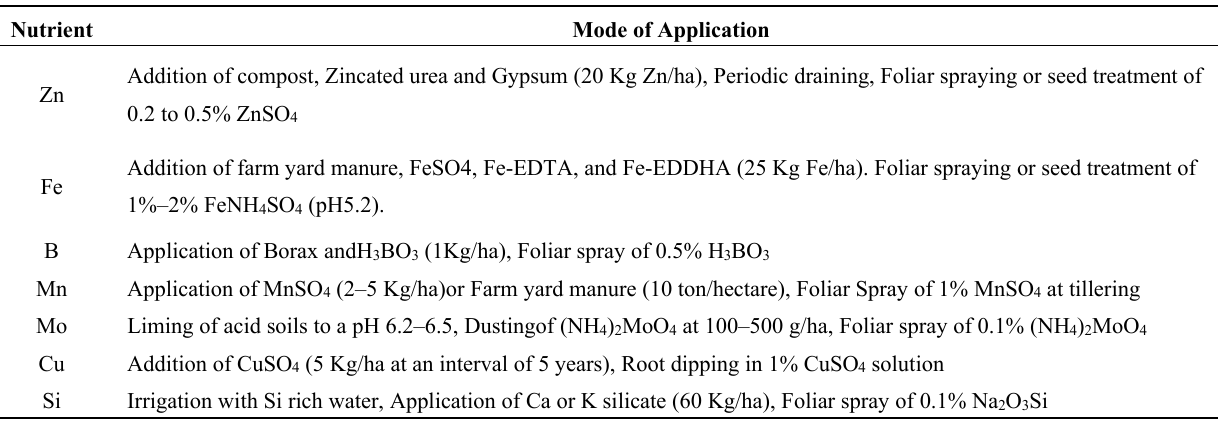
Table 4. TEs supplementpracticesapplicable to rice